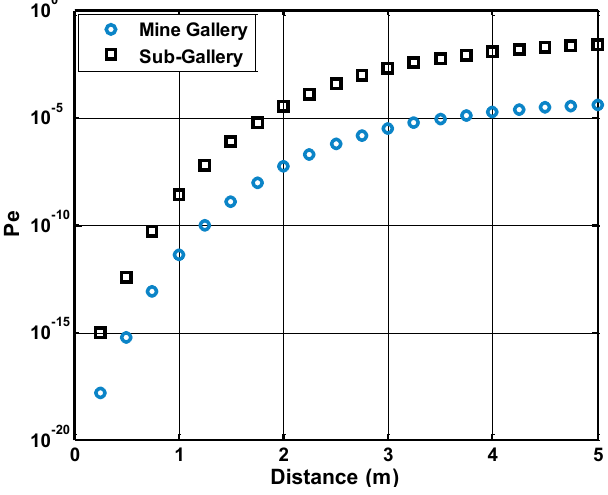
Figure 14. Probability of error as a function of distance to estimate the shadowing effect for